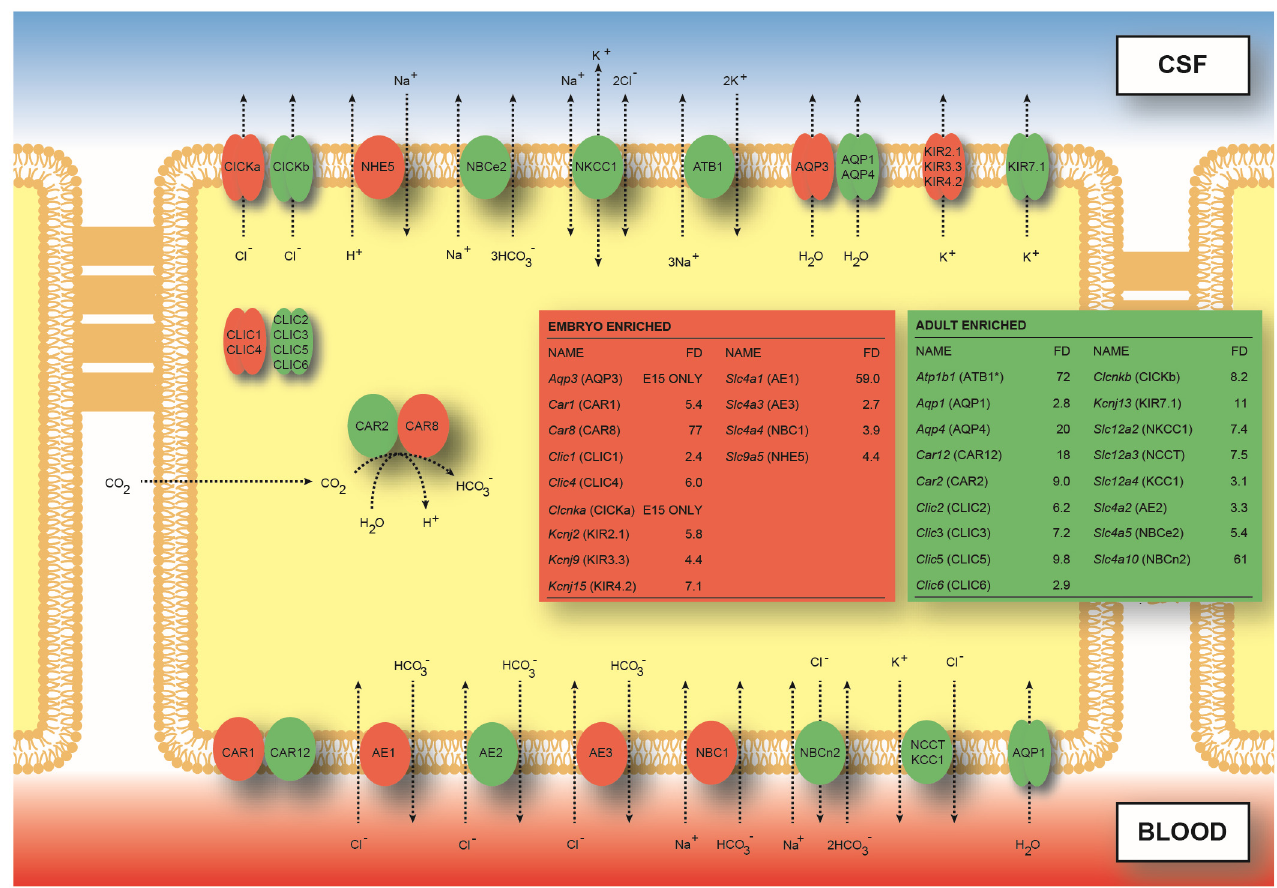
Fig 2. Localization of proteins for ion transporters, channels and associated enzymes and identification of their corresponding genes in adult and immature rat choroid plexus. Data for the localisation of the proteins are from Damkier et al. (2010) and see also Tables 3 and 4. CSF secretion results from coordinated transport of ions and water from basolateral membrane to cytoplasm, then sequentially across apical membrane into ventricles (for review see Davson & Segal, 1996). On the plasma-facing membrane is parallel Cl - /HCO 3- exchange (AE2, Slc4a2 ) and Na + /HCO 3- co-transport (NBC1, Slc4a4 ) with net function bringing Cl - into cells in exchange for HCO 3- (Murphy & Johanson, 1989). Also basolaterally located is Na-dependent Cl - /HCO 3- exchange (NCBn2 Slc4a10 ) that modulates pH and perhaps CSF formation (Damkier et al., 2007). Apical Na + influx by NHE5 (Slc9a5) and ATB1 ( Atb1b1 , Na + /K + - ATPase, asterisk) maintains a low cell Na + that sets up a favorable basolateral gradient to drive Na + uptake (Pollay et al., 1985). Na + is extruded into CSF mainly via the Na + /K + -ATPase pump (ATB1, Atb1b1 ) and, under some conditions, the Na + /K +/ -Cl - co-transporter NKCC1, Slc12a2 , see Johanson et al., 2008 for review). Overall cell volume is maintained by the K + /Cl - co-transporters NCCT ( Slc12a3 ) and KCC1 ( Slc12a4 ). Aquaporin (AQP1/3/4) channels on CSF- facing membrane mediate water flux into ventricles (Oshio et al., 2005). Polarized distribution of carbonic anhydrase (CAR) and Na + /K + -ATPase, and aquaporins, enable net ion and water translocation to CSF (see Johanson et al., 2008 and Brian et al., 2010 for review). The gene Slc4a7 (NBCn1) was not detected by RNA-Seq, although it has been reported in both rat and mouse choroid plexus (Praetorius et al. 2004); this may have been for technical reasons or because of lack of antibody specificity see section “ Limitations of study ” . The genes for Clir (chloride inwardly rectifying) channels has not been previously identified but are probably Clica and Clicb . The gene for VRAC (volume regulated anion channels) is not known (Alexander et al., 2011); see also Table 4. The carbonic anhydrases CAR2 and CAR8 have an intracellular distribution; CAR8 has been shown to lack the characteristic enzyme activity of these proteins (Picaud et al., 2009). It is not known whether it is functional in the embryo. The CLIC chloride channels are also intracellular (Edwards & Kahl, 2010) and as such we have placed them cytosolically, however it is more likely that they sit on the internal membrane of the cell and aid in movement of Cl - to other channels. The inset boxes show the fold differences for genes expressed at a higher level in the embryonic (red) or in the adult (green) choroid